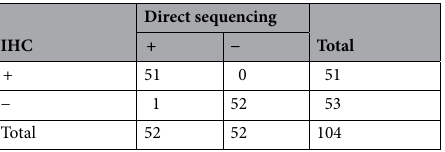
method and the gold standard. The Kappa value was 0.965, which indicated that IHC had the good consistency with the direct sequencing method.